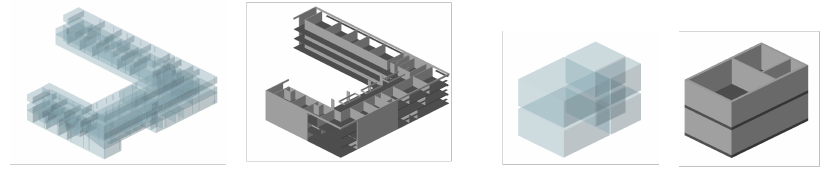
Figure 7. Example conversion results: Revit advanced tutorial office building ( left ) and handcrafted two-storey residential building ( right ). Conversion includes spaces, walls, slabs and roofs, but roofs are omitted for illustrative